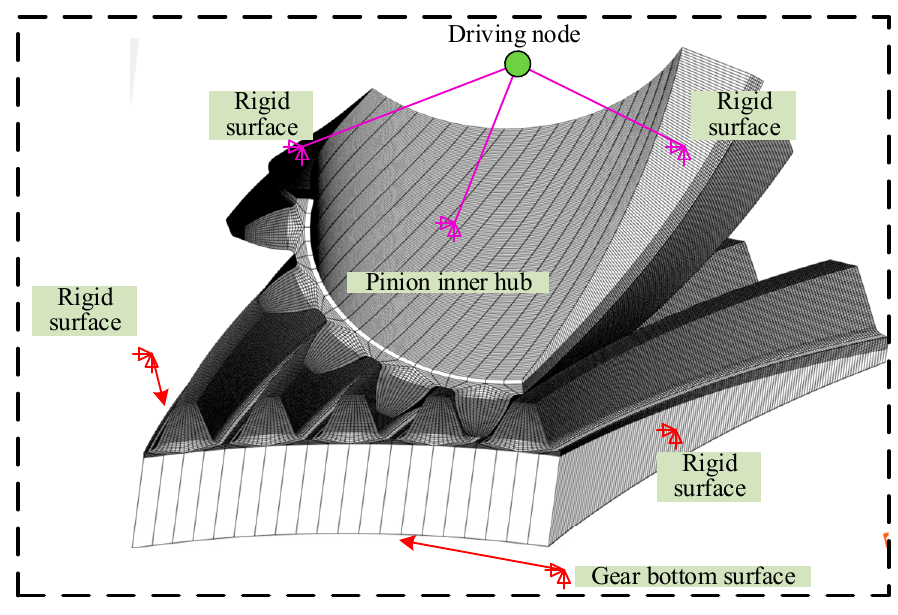
Figure 4. FE model of the SBGP.